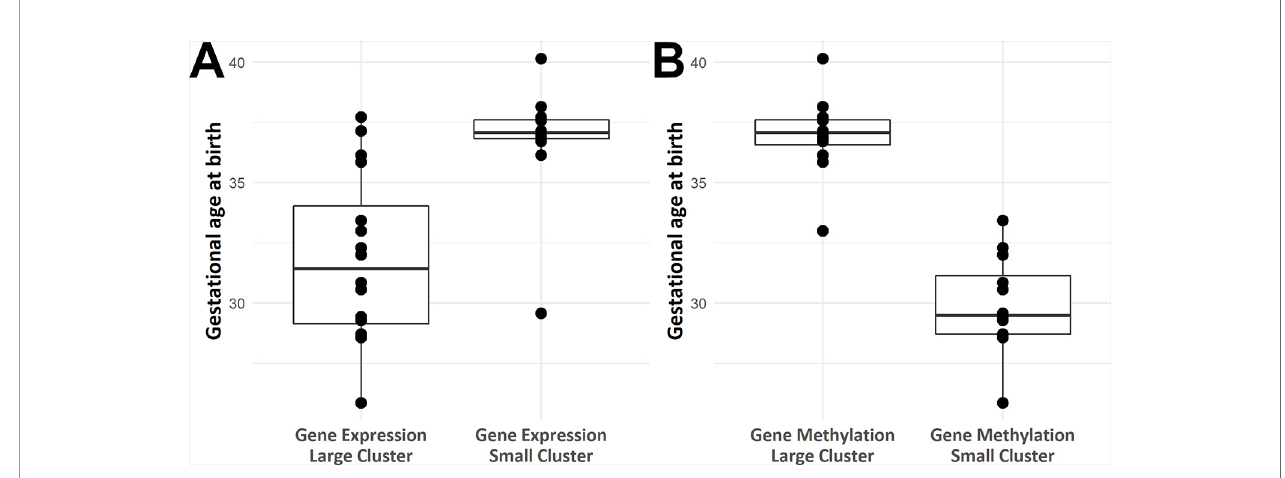
FIGURE 3 | Box plots of gestational age at birth according to IUGR samples position in hierarchical clustering based on methylomics (A) and transcriptomics (B)